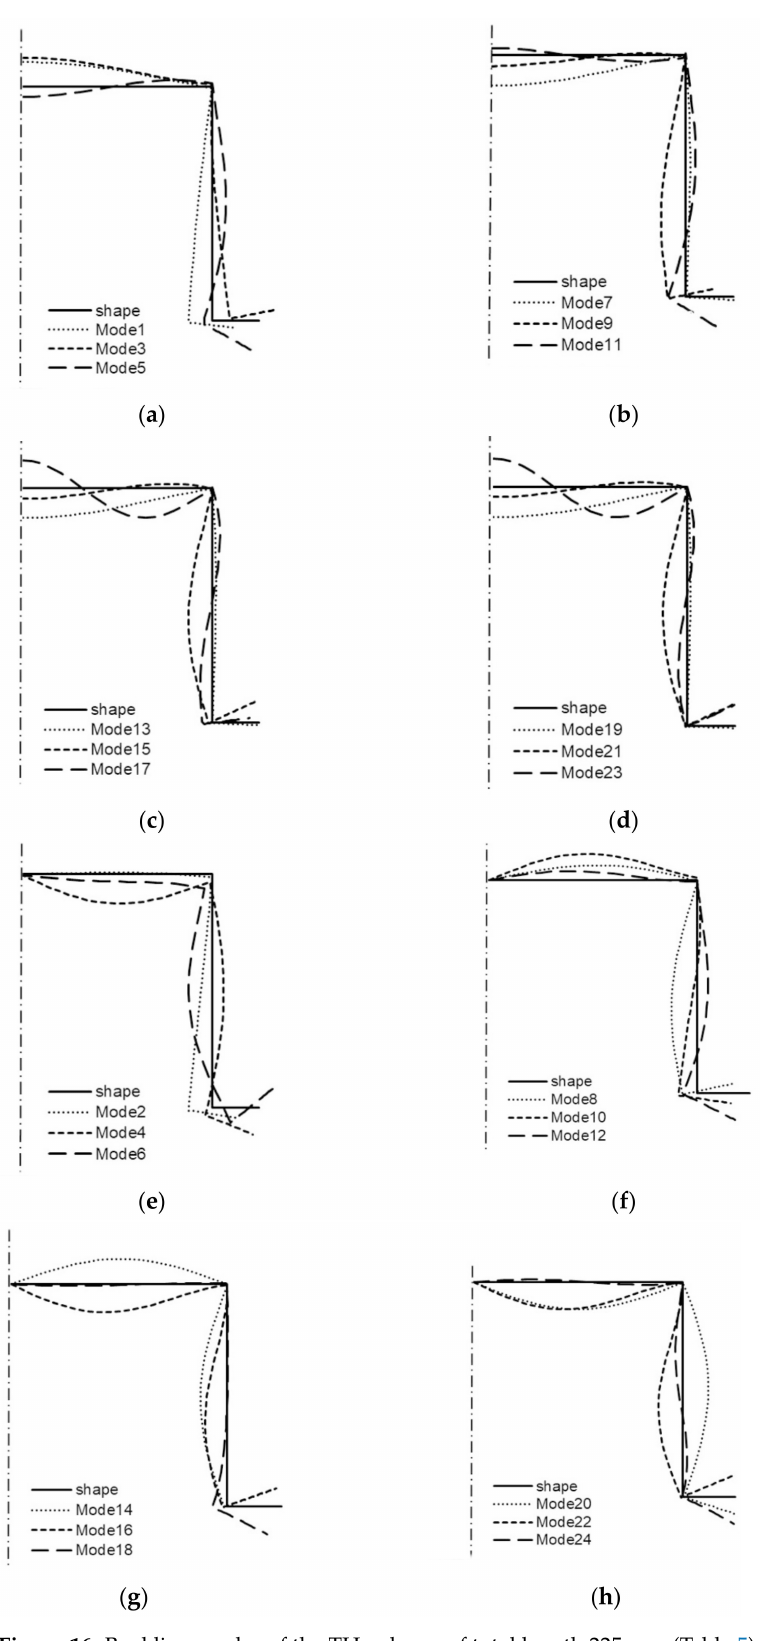
Figure 16. Buckling modes of the TH-column of total length 225 mm (Table 5): symmetrical modes 1, 3, 5 ( a ), modes 7, 9, 11 ( b ), modes 13, 15, 17 ( c ), modes 19, 21, 23 ( d ), and anti-symmetrical modes 2, 4, 6 ( e ), modes 8, 10, 12 ( f ), modes 14, 16, 18 ( g ), modes 20, 22, 24 ( h